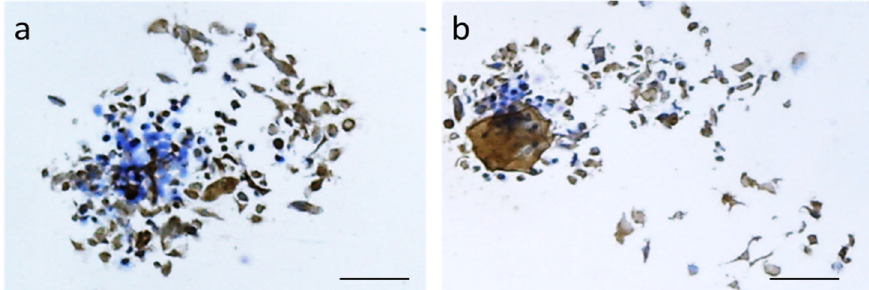
Figure 8. Immunocytochemistry for cytokeratin (revealed in brown) of HaCaT cells cultured for 7 days in: ( a ) unloaded and ( b ) Ag-loaded P(3HB)/P(3HO- co -3HD). Cell nuclei are stained in blue. Scale bar is 50 µm. Original magnification x10×.